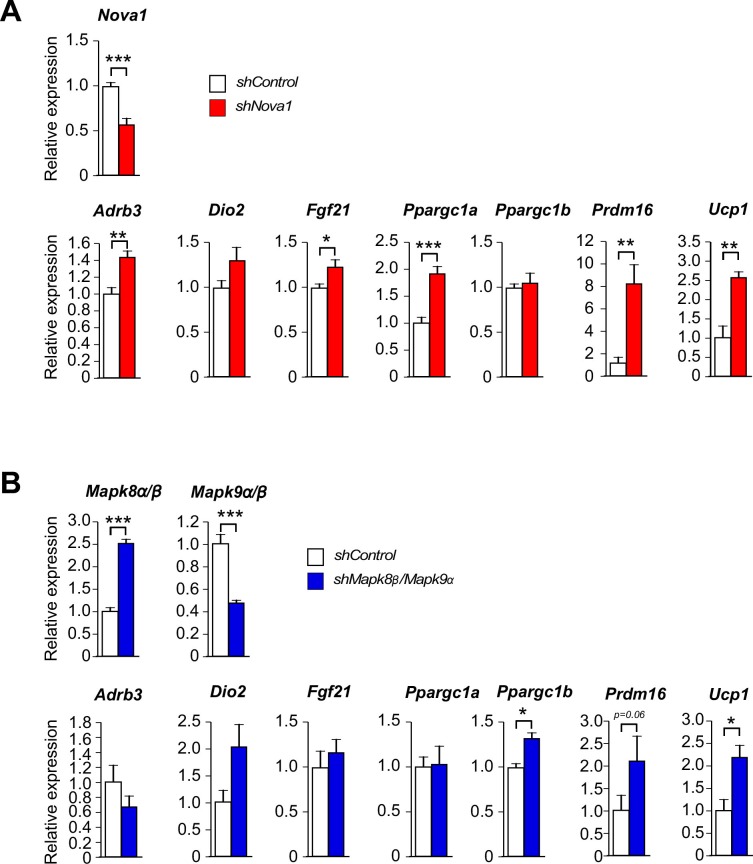
Thermogenic gene expression is increased by shRNA-mediated suppression of Nova1 or Mapk8β/Mapk9α.(A) An shNova1 lentiviral vector was used to suppress Nova1 gene expression in 3T3 L1 adipocytes. Nova2 expression was not detected in these cells. Gene expression was examined by measurement of mRNA by RT-PCR (mean ± SEM; n=6). (B) Lentiviral vectors expressing shMapk8β and shMapk9α were used to suppress Mapk8β and Mapk9α mRNA expression in 3T3 L1 adipocytes. Gene expression was examined by measurement of mRNA by RT-PCR (mean ± SEM; n=6). Statistically significant differences between Control and shRNA knock-down adipocytes are indicated: *p<0.05; **p<0.01; ***p<0.001.